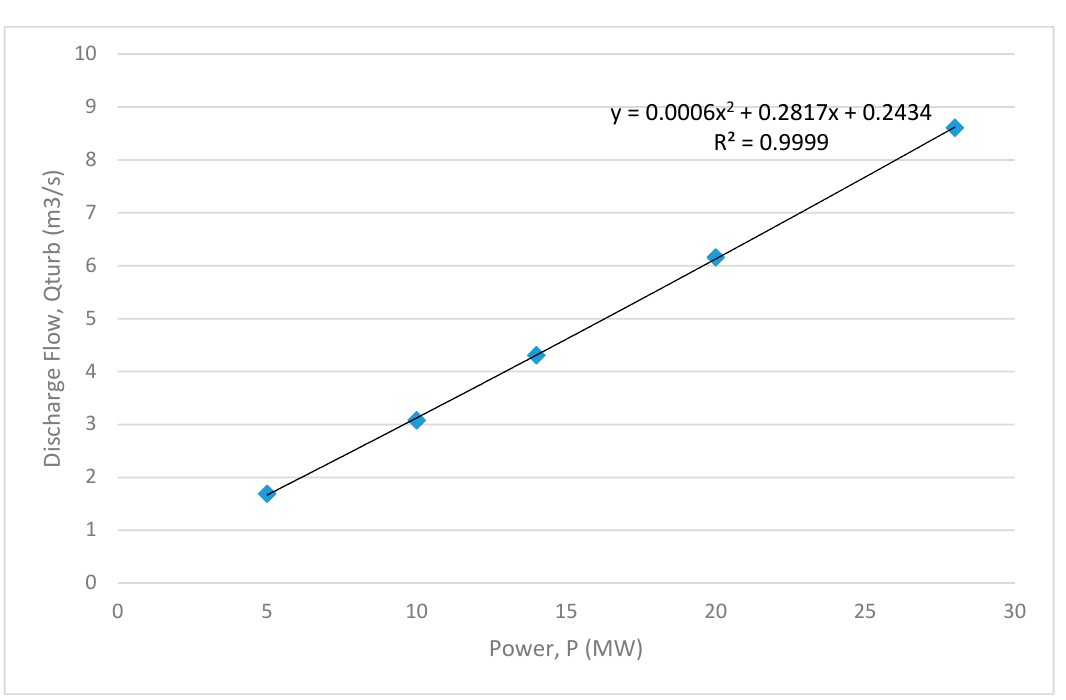
Figure 6. Turbine discharge derived from generator power output.